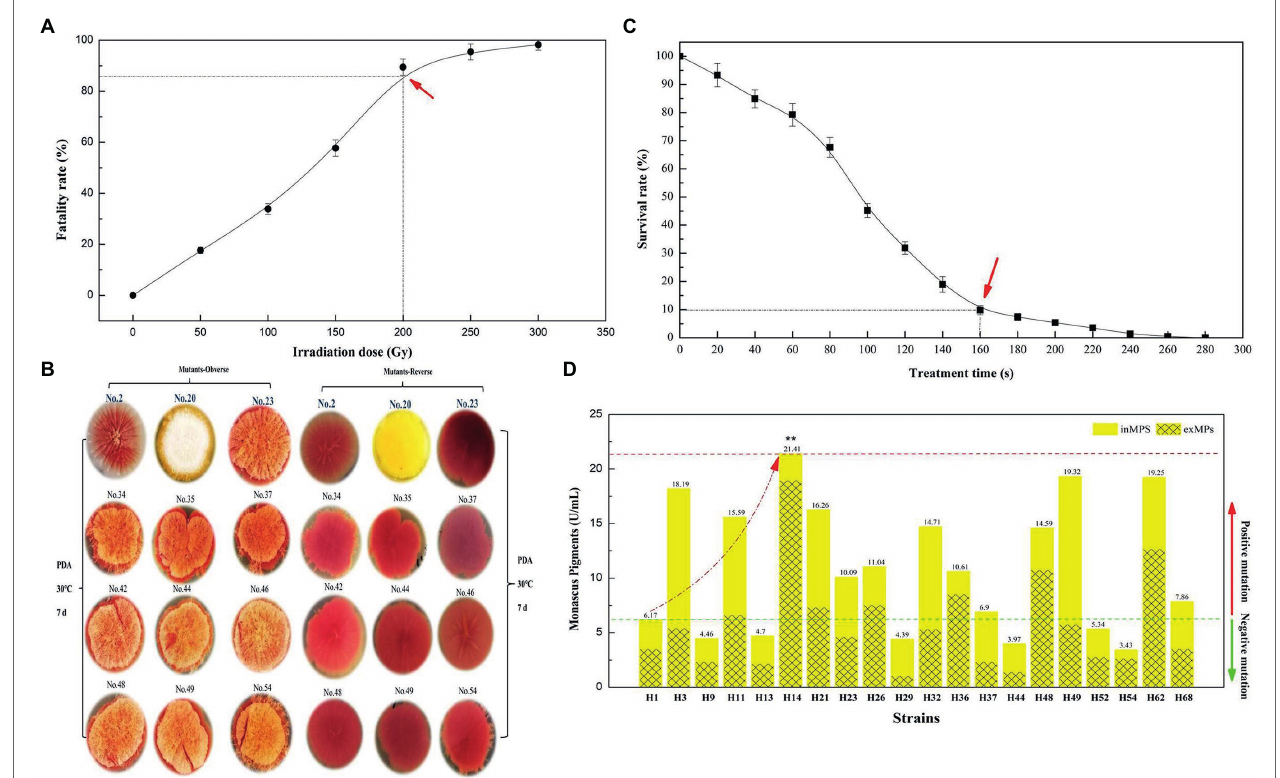
FIGURE 1 | Fatality rate (A) and survival rate (C) of parent strain Monascus purpureus LQ-6 subjected to heavy ion beam irradiation (HIBI) and atmospheric and room-temperature plasma (ARTP) mutation breeding system for various irradiation dose and treatment times, respectively; the morphology and color of mutant strains on potato dextrose agar (PDA) plates (B) ; the production of total yellow monascus pigments by the mutant strains obtained via using ARTP by submerged batch fermentation (SBF) for 10 days at 30 ° C and agitated at 150 rpm in the dark (D)